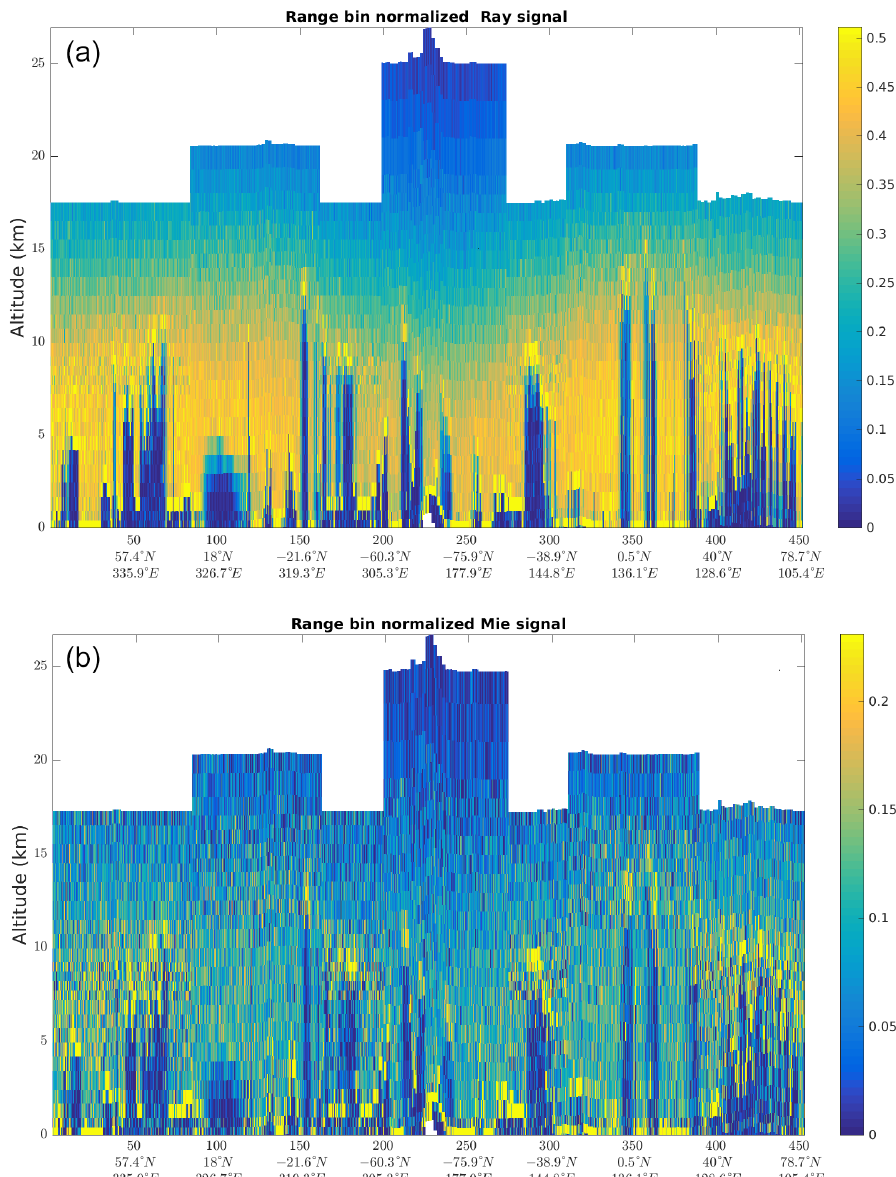
Figure 5. Input signals from the L1B product on orbit file no. 10568. Rayleigh channel (a) and Mie channel (b)